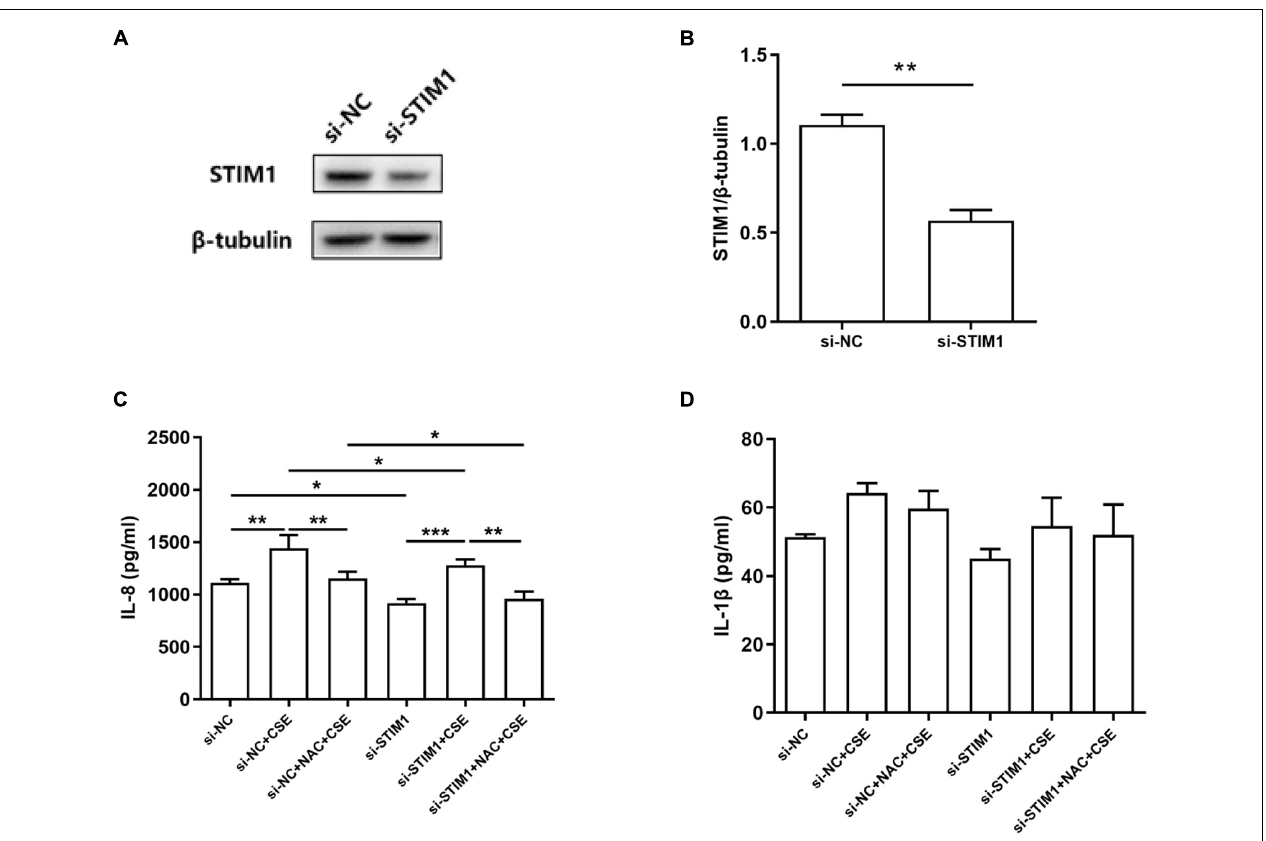
FIGURE 4 | Interleukin-8 (IL-8) induction is mitigated by NAC and STIM1 knockdown in CSE-stimulated PMA-differentiated THP-1 cells. Relative STIM1 expression was detected by western blot in PMA-differentiated THP-1 cells after transfected with small interfering RNA (siRNA)-STIM1 (A) and quantified using ImageJ (B) . P -values were calculated using Student’s t -test of at least three independent experiments. si-NC transfected and si-STIM1 transfected THP-1 cells were pretreated with 3 mM NAC for 1 h, and then the supernatant was collected 48 h after 5% CSE stimulation. The levels of IL-8 and IL-1 β released from the cells are shown (C,D) . Data are expressed as mean ± SEM of at least three independent experiments. P -values were calculated using Student t -test or one-way ANOVA followed by Newman–Keuls test as appropriate. * P < 0.05, ** P < 0.01, and *** P < 0.001 represent significant differences. NC, negative control; STIM1, stromal interaction molecule 1; NAC, N-acetylcysteine; CSE, cigarette smoke extract; and PMA, phorbol myristate